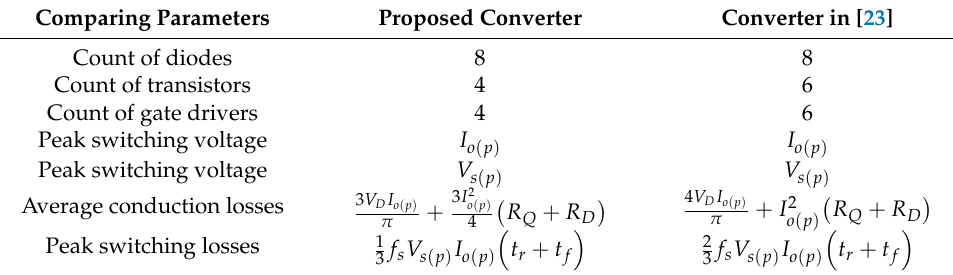
Table 1. Validation of the performance